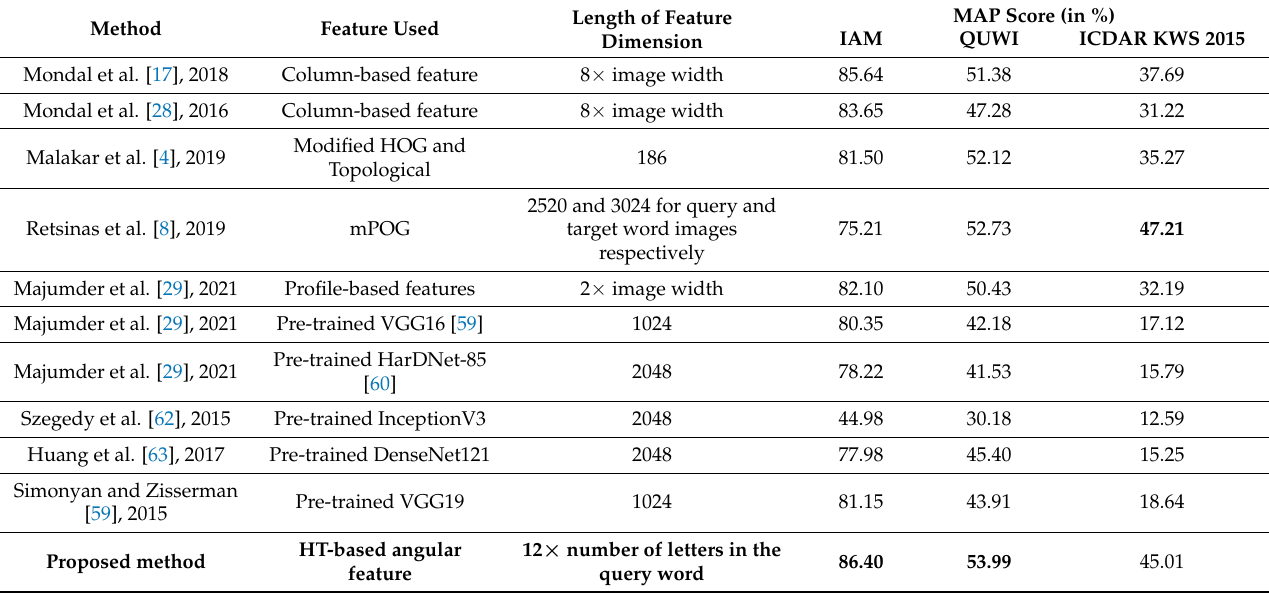
Table 2. Comparative results with state-of-the-art methods in terms of MAP score and feature dimension. The bold faced numbers represent the best scores while bold faced texts represent proposed method